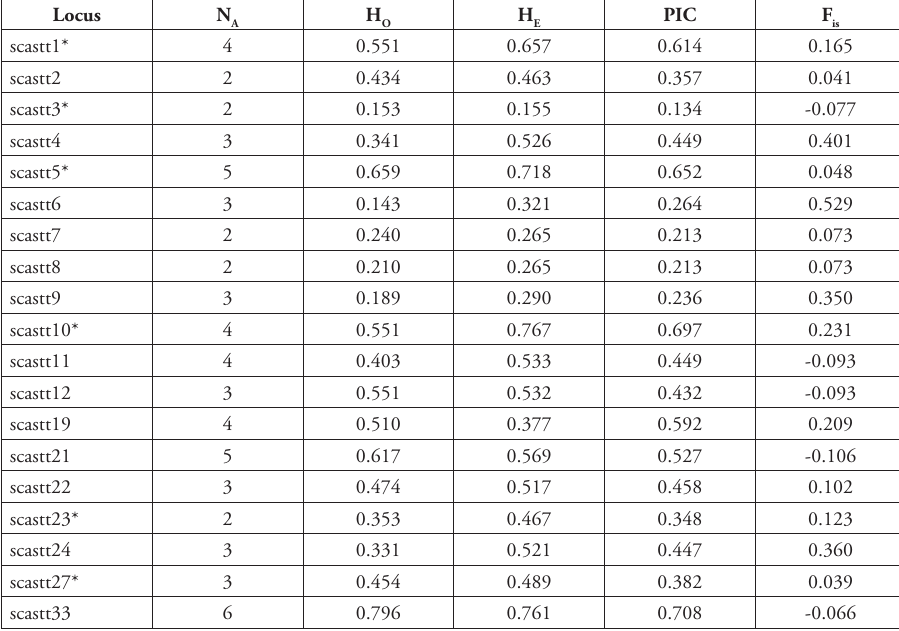
Table 4. Population genetic parameters in three populations of Solenaia carinata. N : the number of al- A leles, H : observed heterozygosity; H : expected heterozygosity. O E Locus N H H PIC F A O E is scastt1* 4 0.551 0.657 0.614 0.165 scastt2 2 0.434 0.463 0.357 0.041 scastt3* 2 0.153 0.155 0.134 -0.077 scastt4 3 0.341 0.526 0.449 0.401 scastt5* 5 0.659 0.718 0.652 0.048 scastt6 3 0.143 0.321 0.264 0.529 scastt7 2 0.240 0.265 0.213 0.073 scastt8 2 0.210 0.265 0.213 0.073 scastt9 3 0.189 0.290 0.236 0.350 scastt10* 4 0.551 0.767 0.697 0.231 scastt11 4 0.403 0.533 0.449 -0.093 scastt12 3 0.551 0.532 0.432 -0.093 scastt19 4 0.510 0.377 0.592 0.209 scastt21 5 0.617 0.569 0.527 -0.106 scastt22 3 0.474 0.517 0.458 0.102 scastt23* 2 0.353 0.467 0.348 0.123 scastt24 3 0.331 0.521 0.447 0.360 scastt27* 3 0.454 0.489 0.382 0.039 scastt33 6 0.796 0.761 0.708 -0.066 Note: *: significant deviations from Hard-Weinberg equilibrium